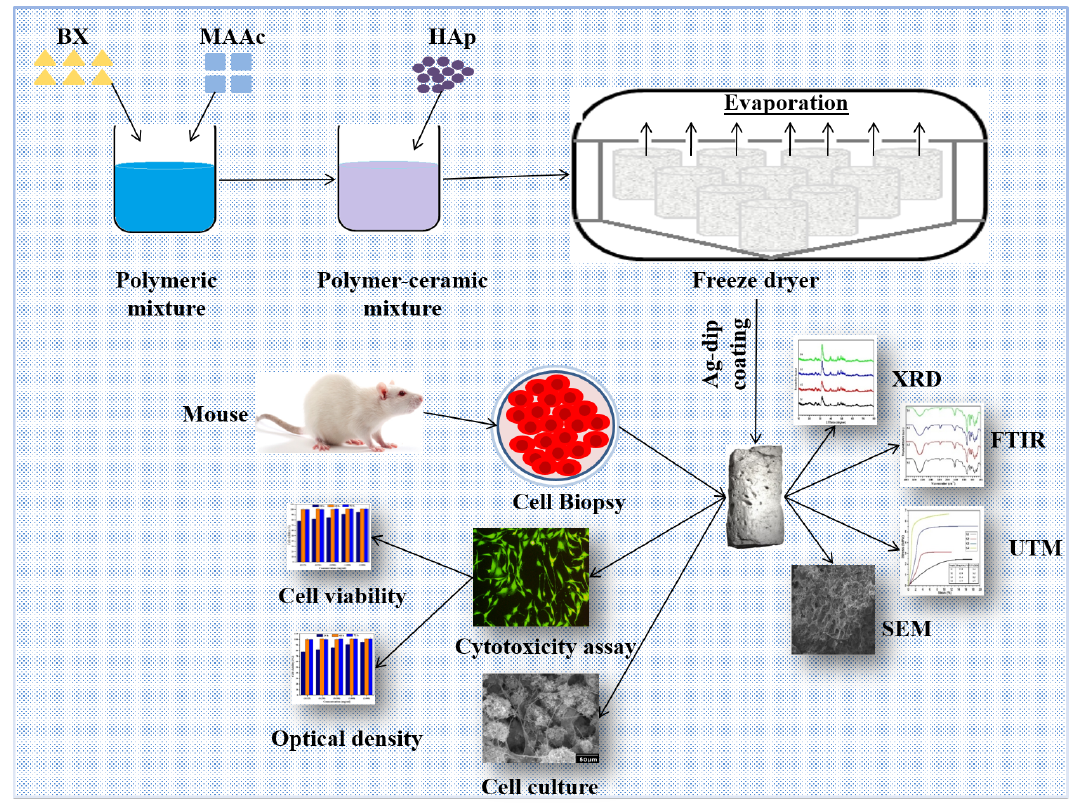
Figure 1. Schematic diagram of the preparation and characterization of a bioactive nanocomposite scaffold (BNS).